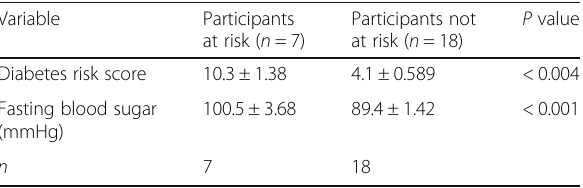
Table 4 DRS and FBS data of both groups (participants at risk and those not at risk). Values are expressed as mean ± SEM, n number of participants Variable